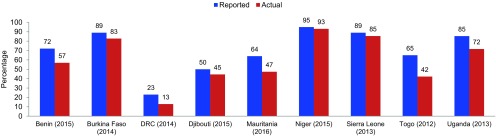
Percentage of Facilities Providing Oral Contraceptives, Reported Compared With ObservedaAbbreviation: DRC, Democratic Republic of the Congo.a Reported percentage refers to percentage of facilities where a SARA survey respondent reported that a health facility is providing oral contraceptive services. Actual percentage refers to the percentage of facilities where a SARA surveyor observed at least 1 valid stock of oral contraceptives in the service area or in a place where they are routinely stored in the health facility, on the day of the assessment